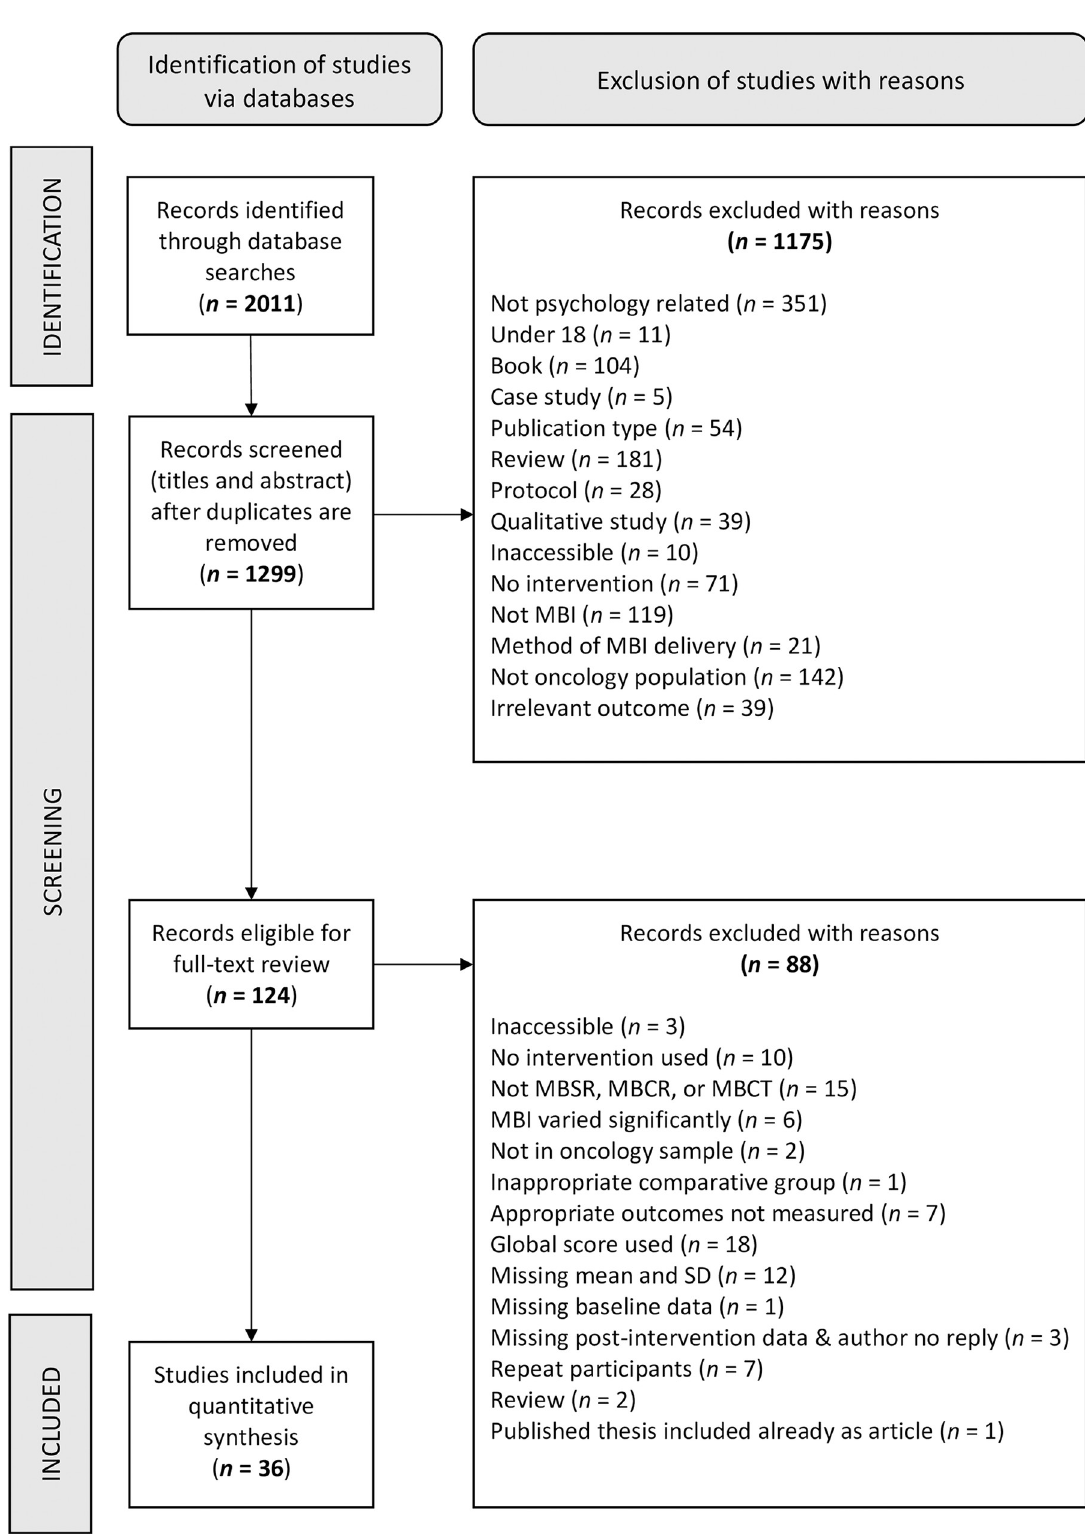
Fig 1. PRISMA flow